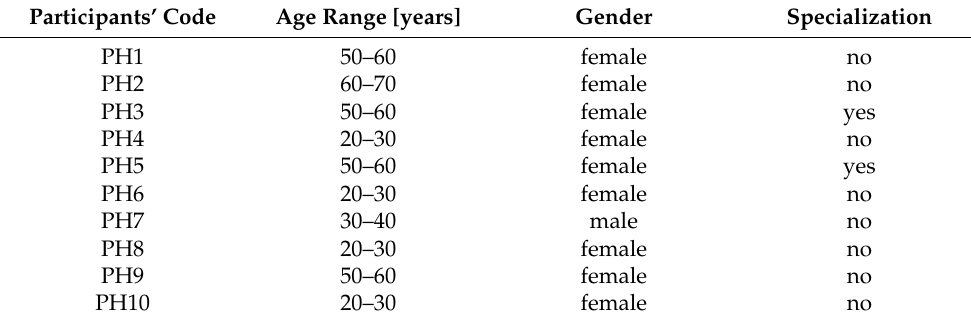
Table 1. Characteristic of the respondents’